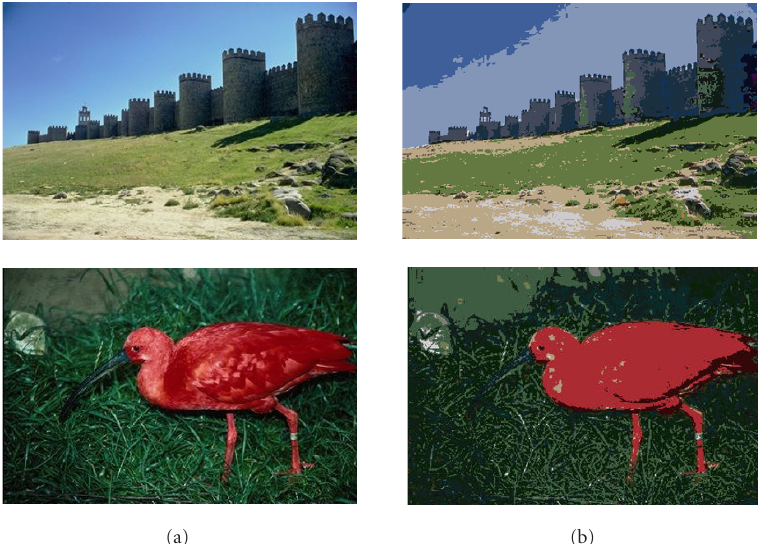
Figure 3: Two examples of images before and after quantization of HSV color space by adaptive k -means in 25 classes. The pixel values are replaced by the color of the class center, here represented in gray. (a) Original image. (b) Color-quantized image.